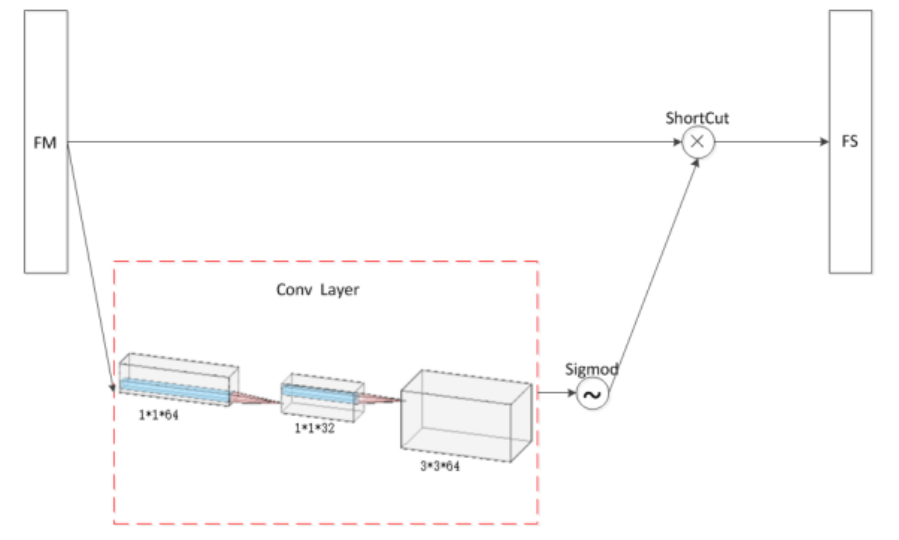
Figure 7. Add attention mechanism based on SAM module (the red box is the improved part).